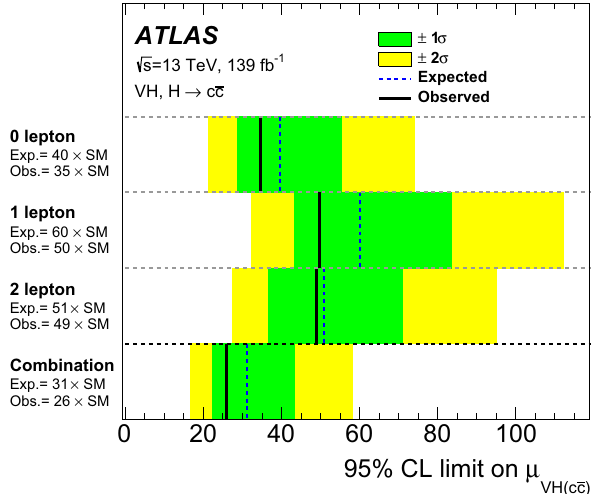
Fig. 2 The observed and expected 95% CL upper limits on the cross- section times branching fraction normalized to its SM prediction in each lepton channel and for the combined fit. The single-channel limits are obtained using a five-POI fit, in which each channel has a separate V H ( → c ¯ c ) parameter of interest ¯ V H , H → c ¯ c and V H , H → b b signal strengths,